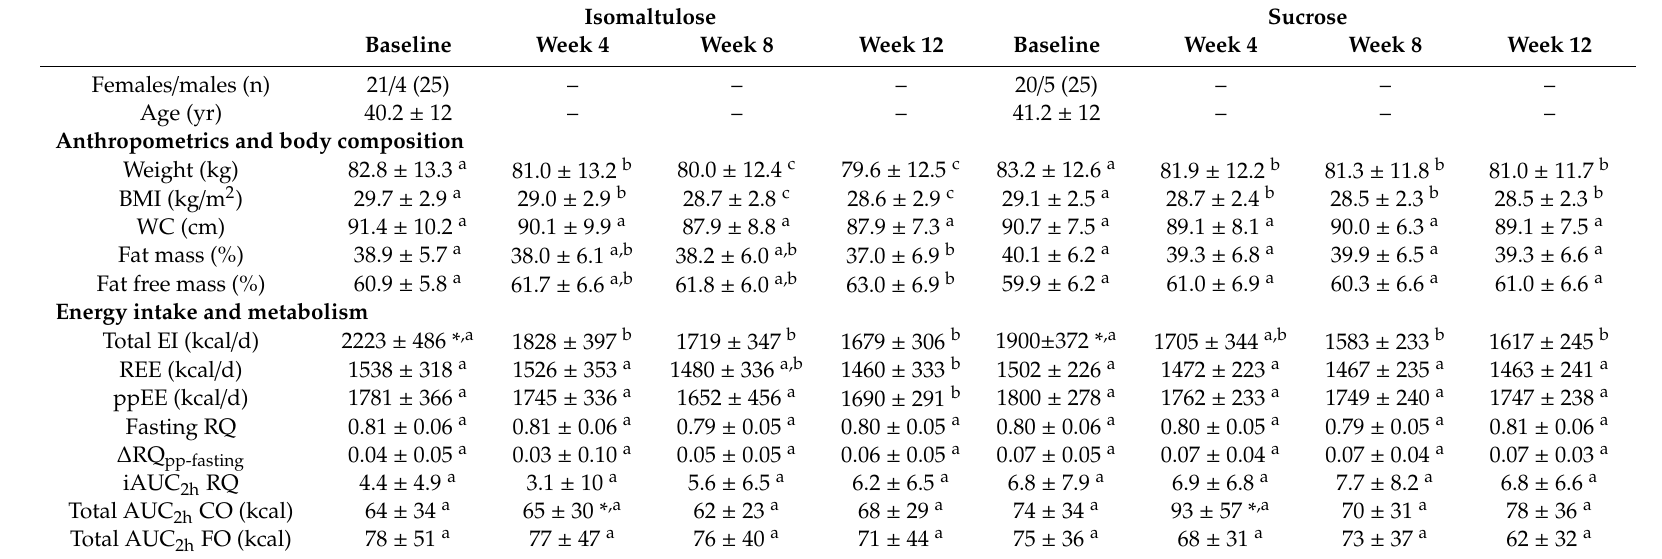
Table 1. Anthropometrics, body composition, and energy metabolism of subjects before, during, and after the 12-week intervention (mean ± SD). Isomaltulose Sucrose Baseline Week 4